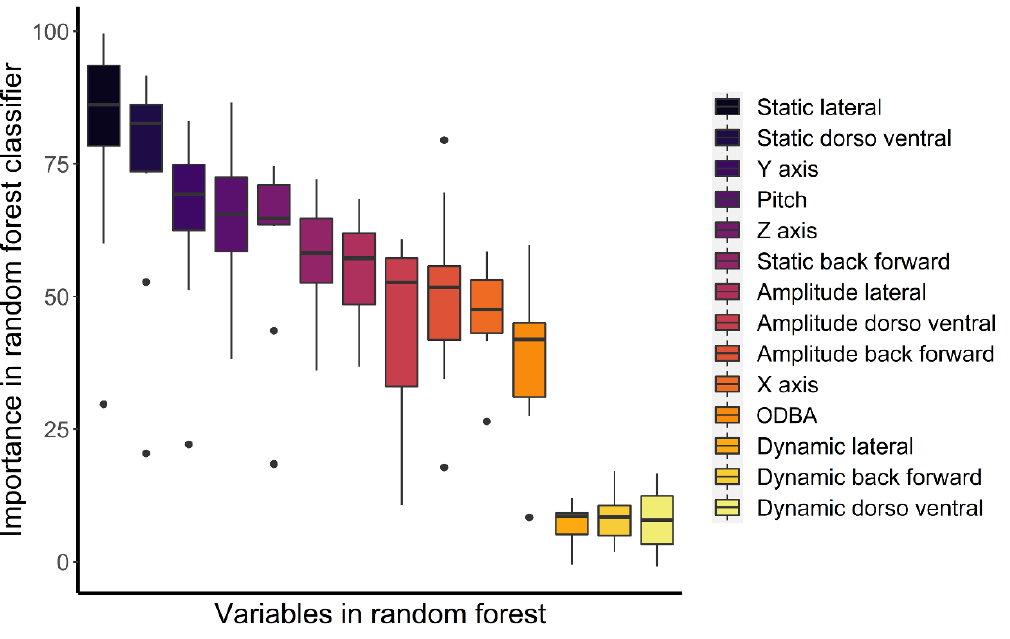
Figure 3. Mean decrease accuracy and mean decrease GINI of the predictor variables included in the random forest classifier.